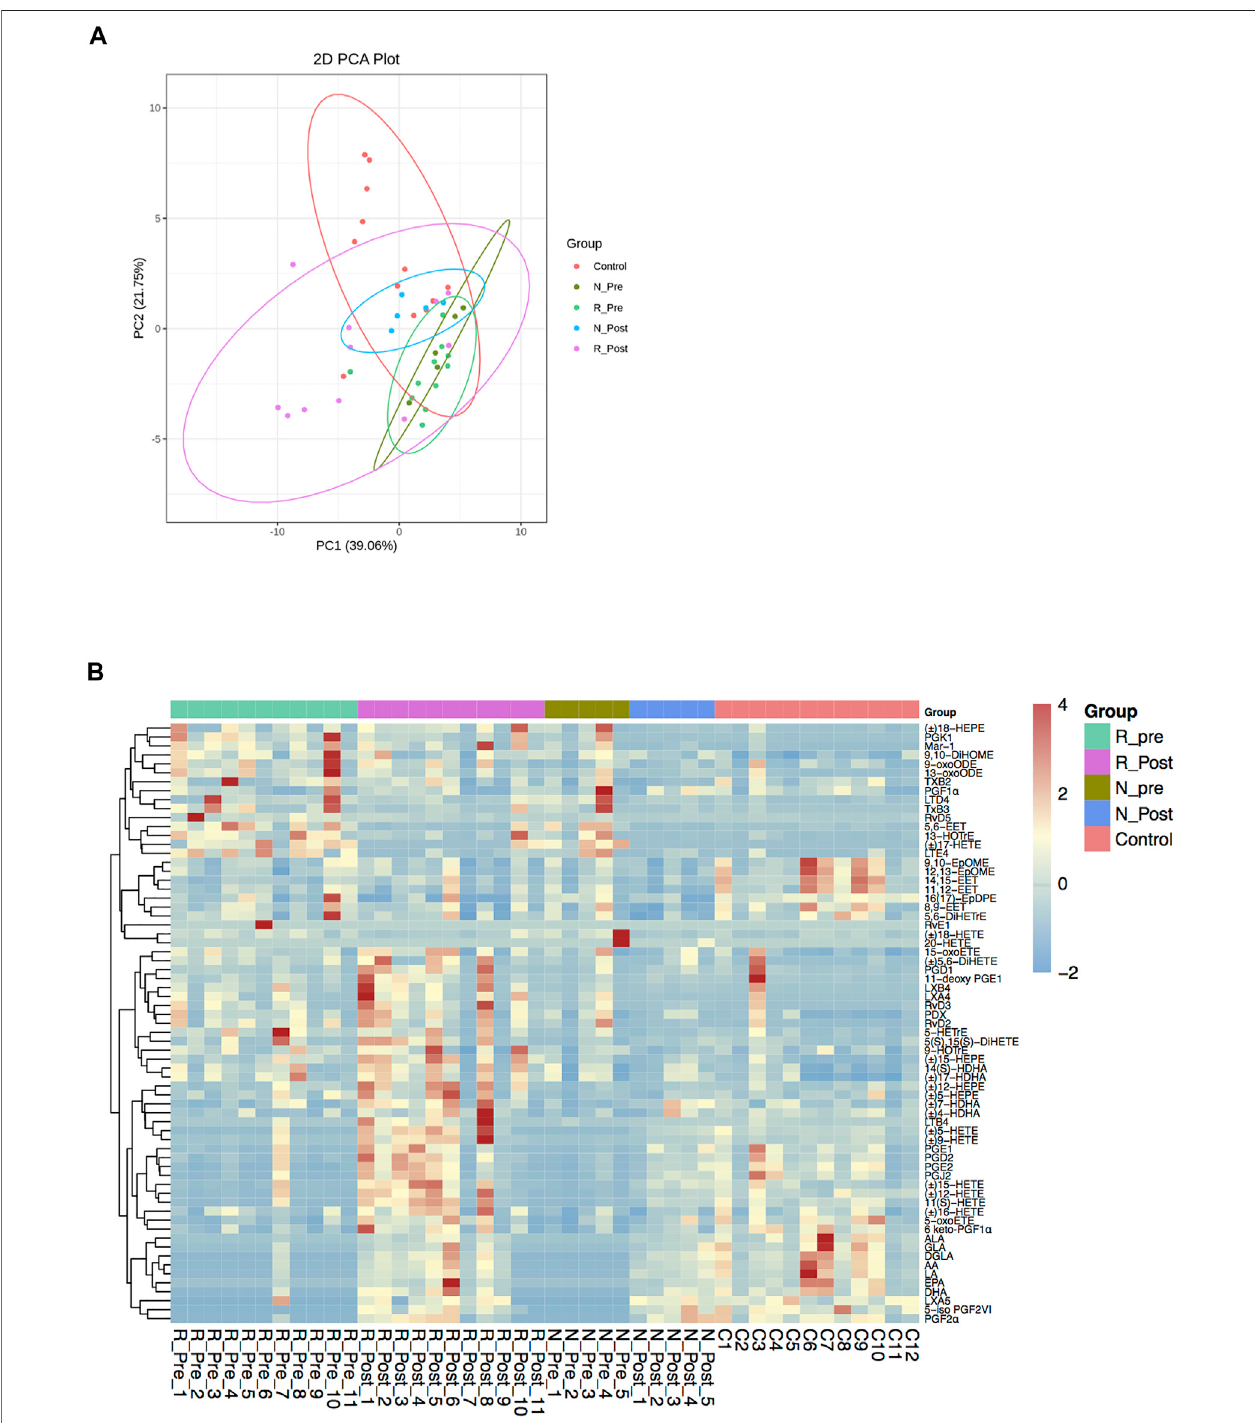
FIGURE 4 | Pro fi les of oxylipid mediators. Principal component analysis (PCA) of oxidative lipidomics (A) and heatmap of the oxylipid mediators (B) in R_Pre ( n (cid:1) 11),R_Post( n (cid:1) 11),N_Pre( n (cid:1) 5),N_Post( n (cid:1) 5),andControl( n (cid:1) 12)groups.Abbreviation:AA,arachidonicacid;ALA, α -linolenicacid;DGLA,dihomo- γ -linolenicacid; DHA, docosahexaenoicacid;DiHETrE,dihydroxy-eicosatrienoic acid;DiHOME,dihydroxy-octadecenoic acid;EET,epoxy-eicosatrienoicacids;EPA,eicosapentaenoic acid; EpDPE, epoxy-docosapentaenoic acid; EpOME, epoxy-octadecenoic acid; GLA, γ -linolenic acid; HDHA, hydroxy-docosahexaenoic acid; HEPE, hydroxy- eicosapentaenoic acid; HETE, hydroxy-eicosatetraenoic acid; HOTrE, hydroxy-octadecatrienoic acid; LA, linoleic acid; LT, leukotriene; LX, lipoxin; Mar, maresin; oxoETE, oxo-eicosatetraenoic acid; oxoODE, oxo-octadecadienoic acid; PD, Protectin; PG, prostaglandin; Rv, resolvins; TX, thromboxane.